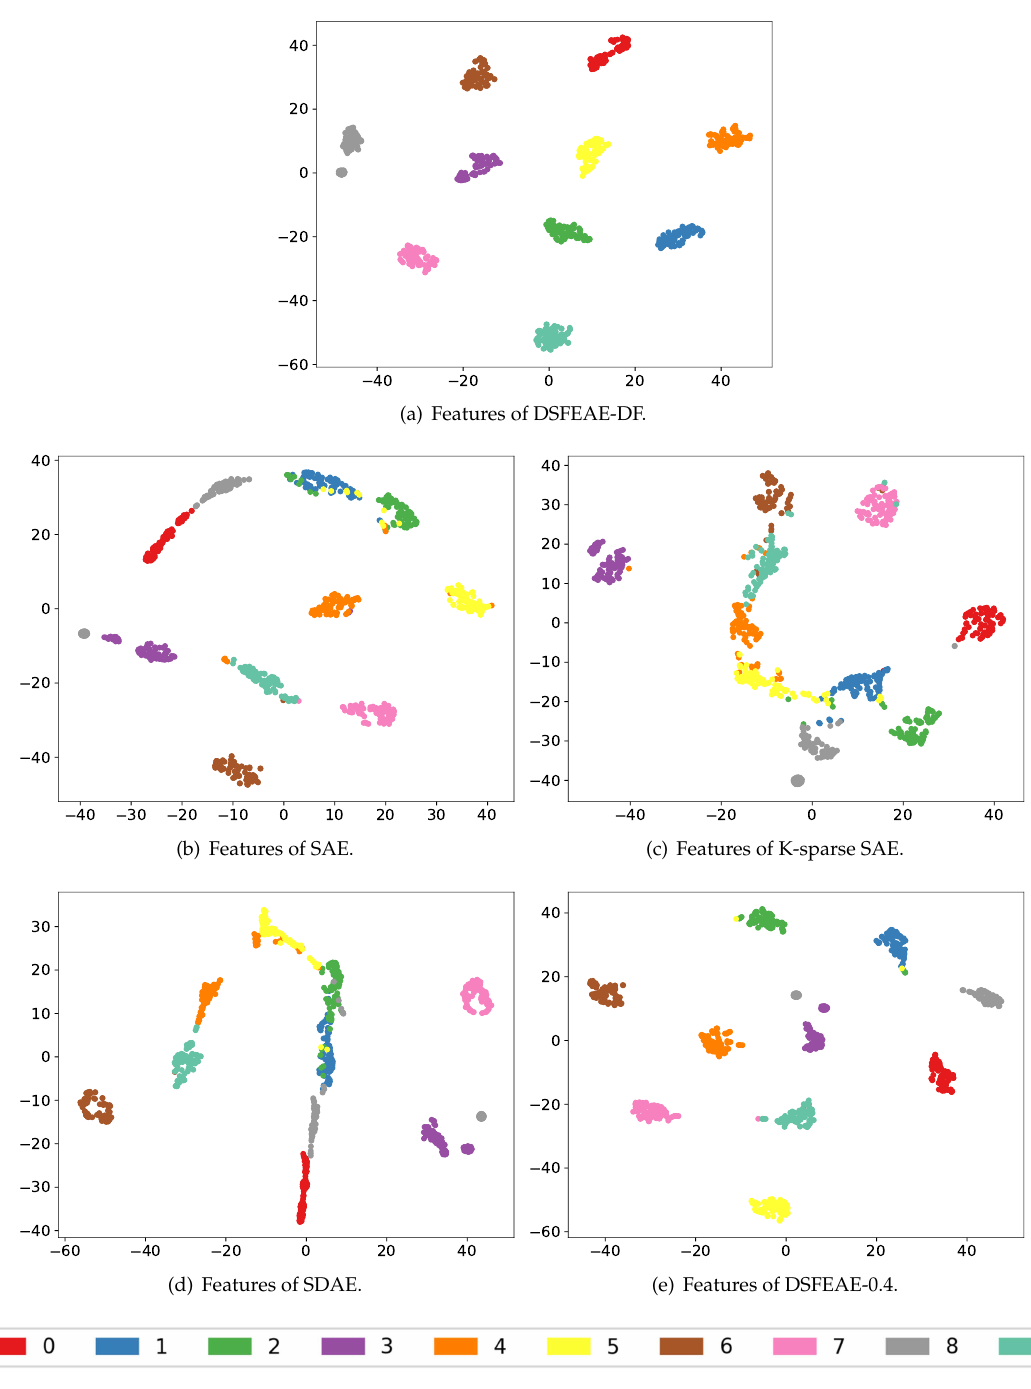
Figure 7. Features of five